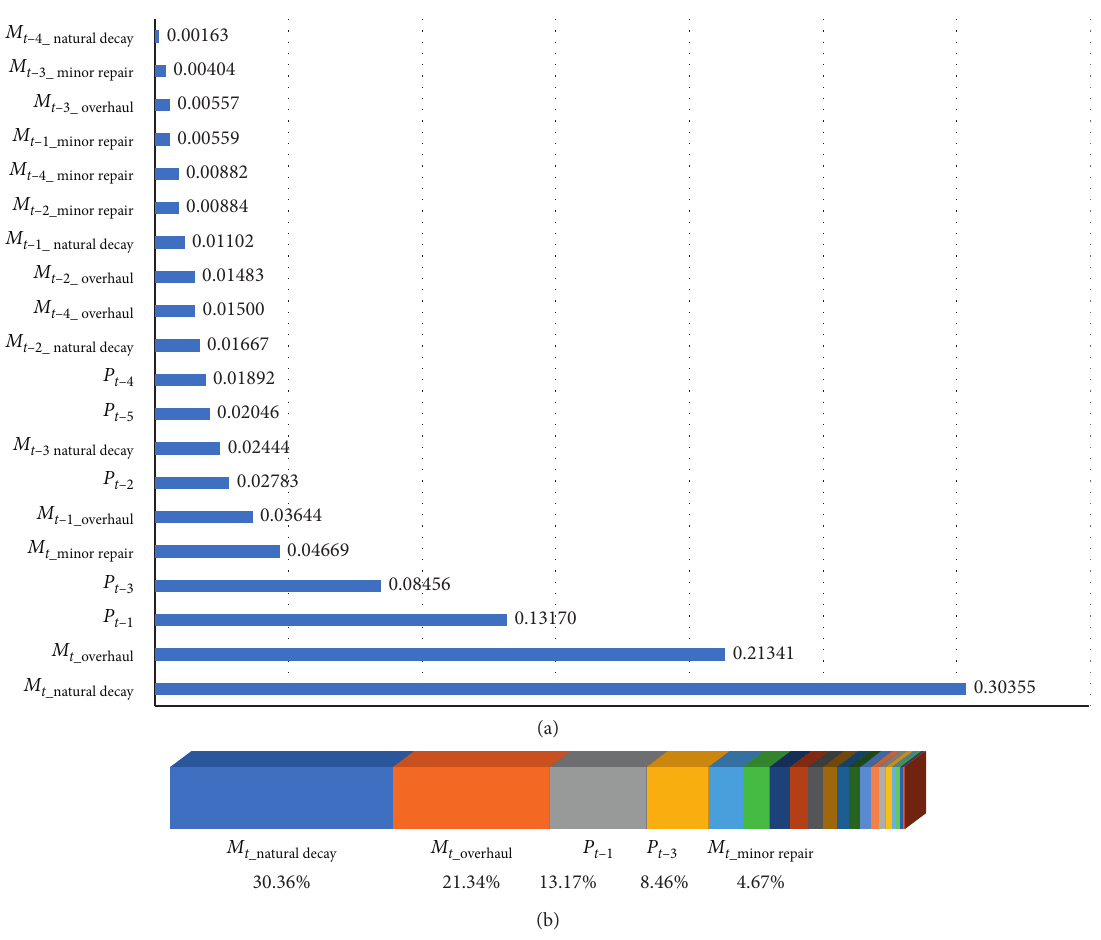
Figure 12: Feature significance. Table 4: Prediction error considering time series features.